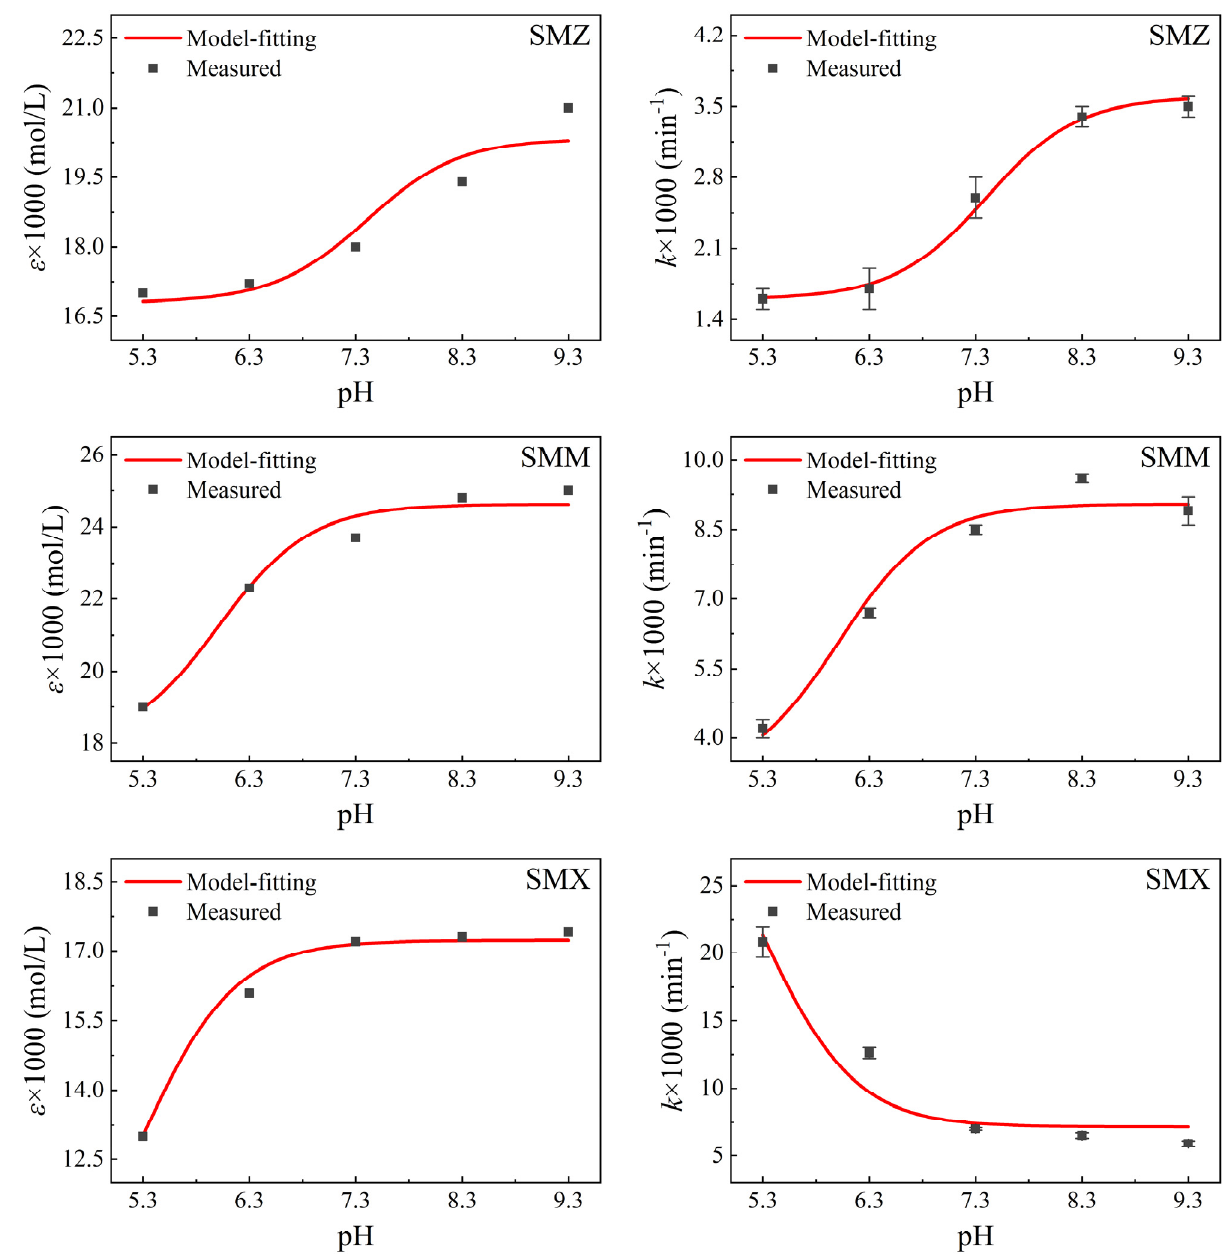
Figure 7. Results of model fitting or measurement for the sulfonamides.